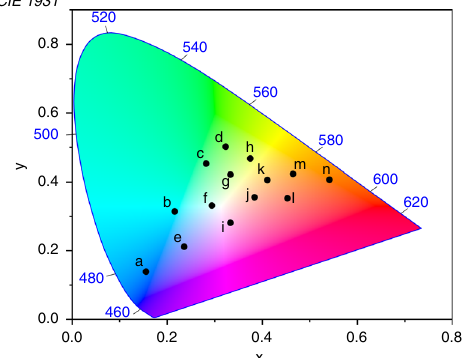
Fig. 5 Full-color reproduction. CIE coordinates for the emission from the tri- component micelle cocktail after isomerization of both DAE derivatives to different extent. Please note that all underlying spectra were recorded upon excitation at one and the same wavelength (423 nm). Irradiation conditions: a no irradiation prior to excitation for emission readout; b 220